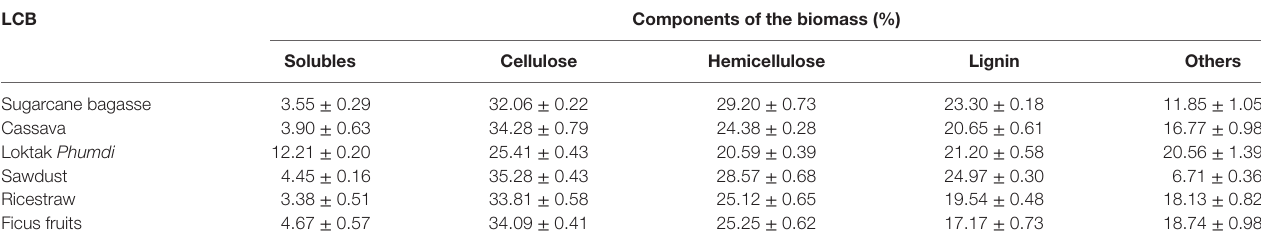
TaBle 1 | Composition of selected lignocellulosic biomass (LCB) available in Indo-Burma biodiversity